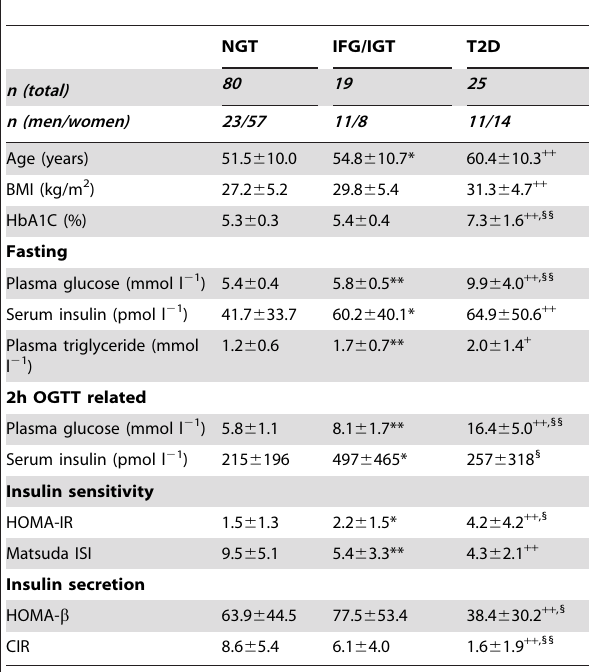
Table 1. Clinical characteristics of the FDR group (n=124) stratified according to glucose tolerance